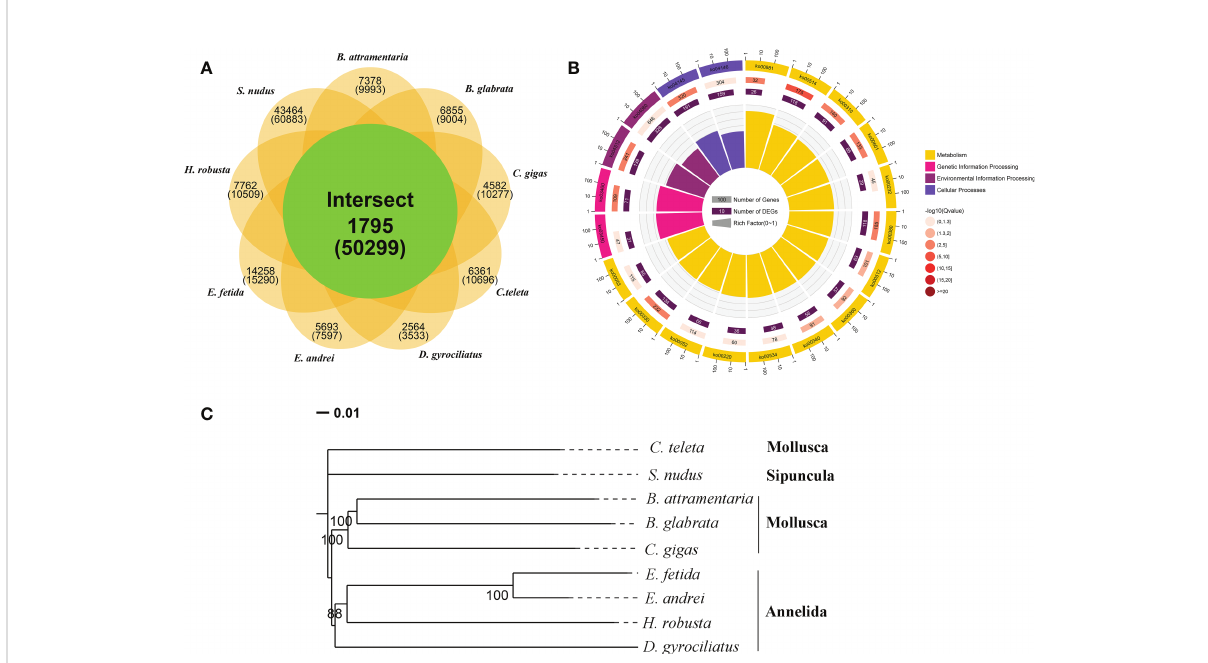
FIGURE 2 Genome comparison and phylogenetic analysis. (A) Venn diagram exhibiting the core and special gene family in nine species; (B) The functional enrichment analysis of special genes in S. nudus using KEGG annotation. The outermost ring represents the top 20 of pathway enrichment. Then, from outside to inside, four rings represent the pathway ID, number of all genes in the pathway, number of special genes in the pathway and classi fi cation of pathway. (C) Phylogenetic relationships among mollusca , sipuncula and annelida base on single copy homologous genes. Batillaria attramentaria : B attramentaria ; Biomphalaria glabrata : B glabrata ; Capitella teleta : C teleta ; Crassostrea gigas : C gigas ; Dimorphilus gyrociliatus : D gyrociliatus ; Eisenia fetida : Efetida ; Eisenia Andrei : E Andrei ; Helobdella robusta : H robusta